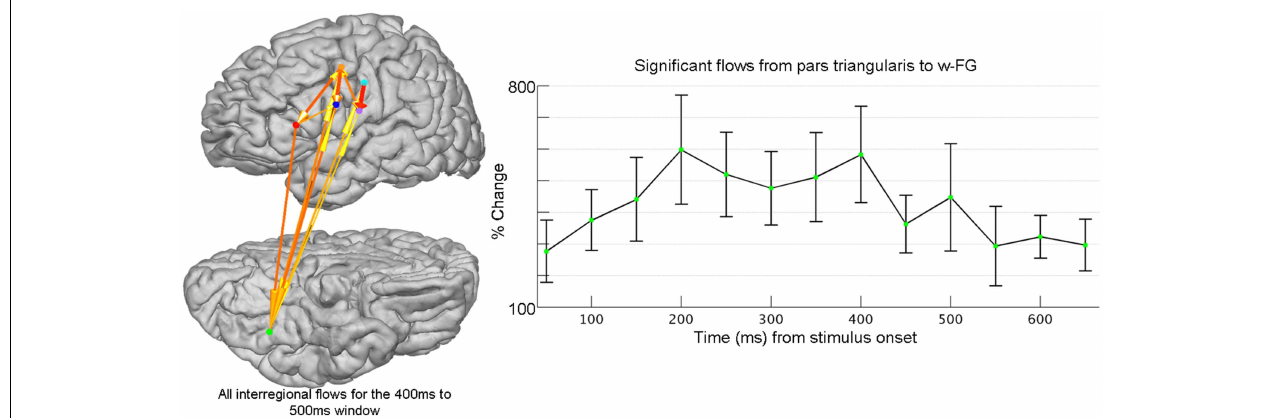
error of the mean) from pars triangularis to word-preferential areas in fusiform gyrus (w-FG) that achieved significance. Electrodes for each region (colored spheres) have been identified using SB-MEMA (not shown). The cortical model to the left (lateral view at top, ventral view at bottom; left hemisphere) provides a snapshot of significant flows for the cortical reading network at 400ms after stimulus onset (w-FG is shown in green and pars triangularis is shown in red). The ability to study long-distance cortical network interactions at millisecond resolution is a unique advantage of grouped icEEG, and enables the critical evaluation of hypotheses regarding functional network